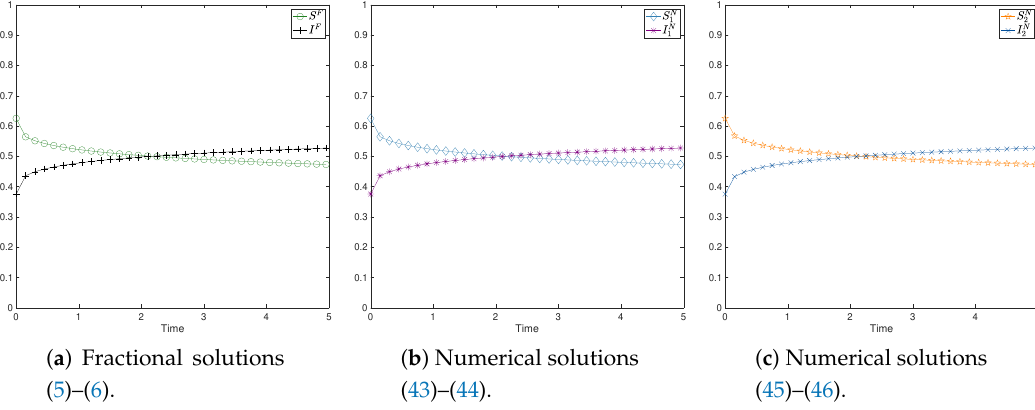
Figure 3. Comparison between the explicit and numerical fractional solutions to (1) with α = 0.3.